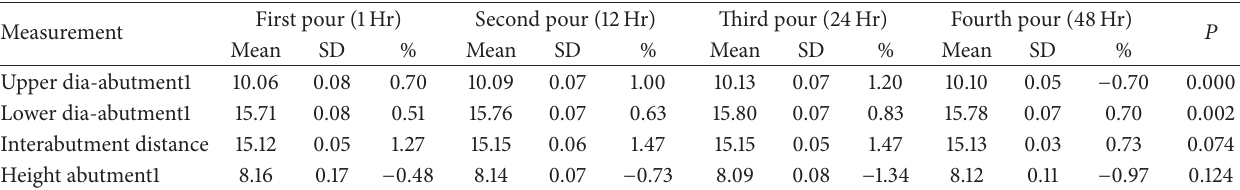
Table 3: The mean measurement values of stone dies, standard errors, and percentage of errors from master cast from Monophase impression technique.